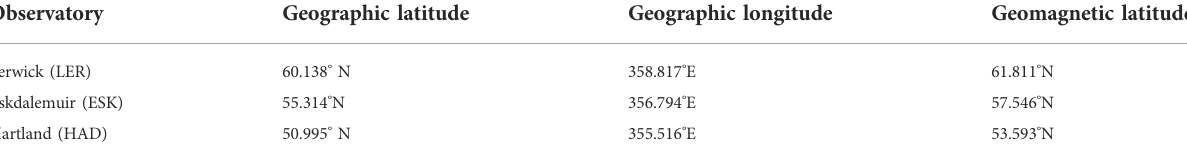
TABLE 1 Observatory locations with geomagnetic coordinates in year